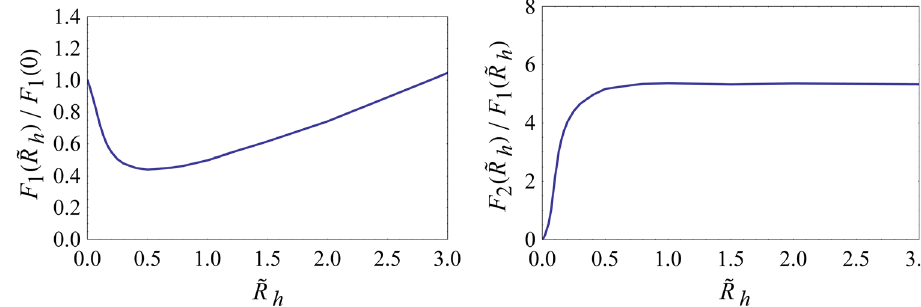
Fig. 3 The dimensionless quantities F 1 and F 2 , that determine the ratio δ M tot / T , as a function of the rescaled black-hole